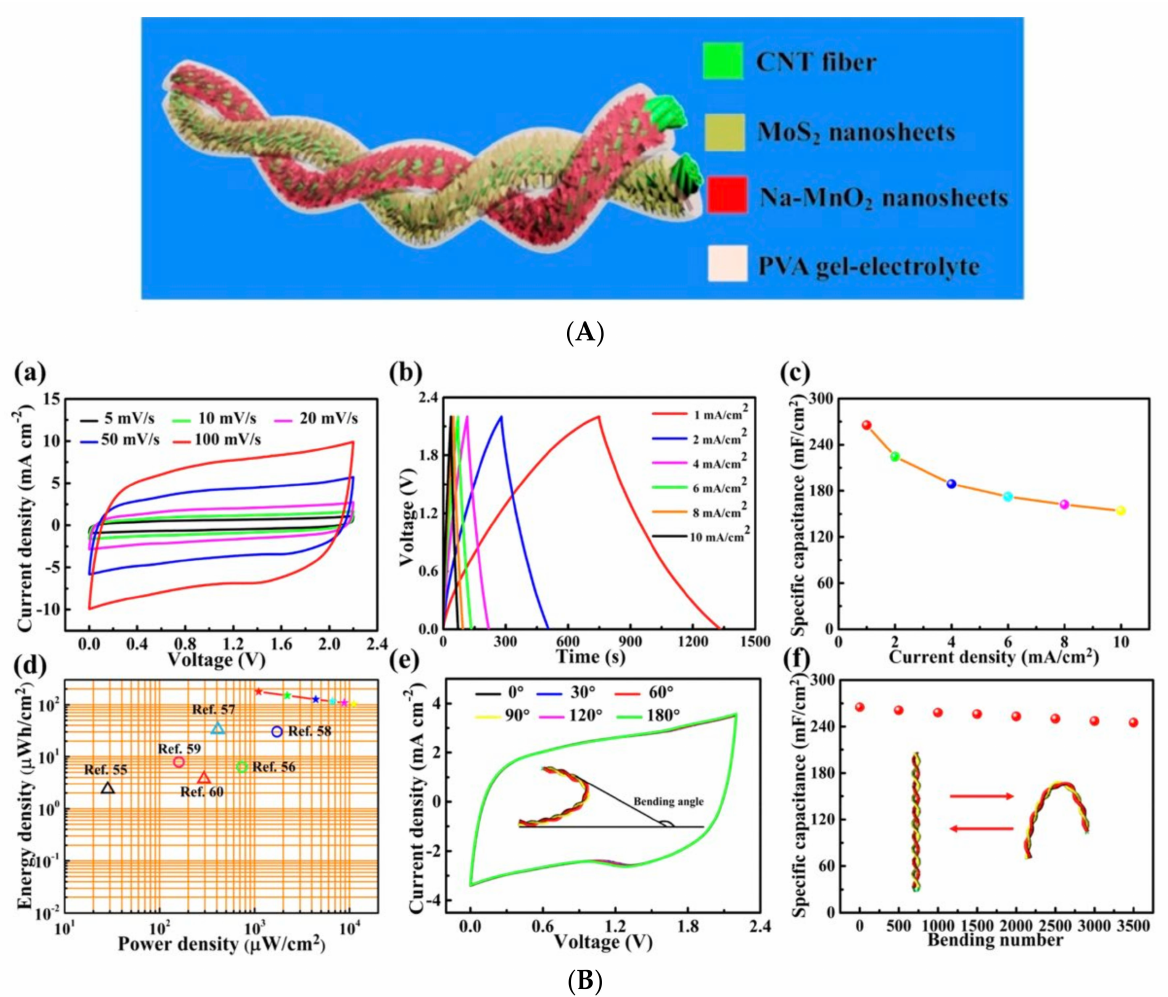
Figure 11. ( A ) Detailed illustration of the fiber shaped asymmetric supercapacitors (FASCs) ( B ) Elec- trochemical study of the FASCs: ( a ) FASC CV curves at various scanning rates of 5–100 mV/s; ( b ) GCD curves with different current densities of 1–10 mA/cm 2 ; ( c ) areal specific capacitance as a function of the current density; ( d ) FASC power density and areal energy density compared to previous FSCs; ( e ) CV curves of the FASCs under various bending angles; ( f ) capacitance retention of the FASCs exposed to bending angles of 120 ◦ for 3500 cycles. Reproduced with permission from